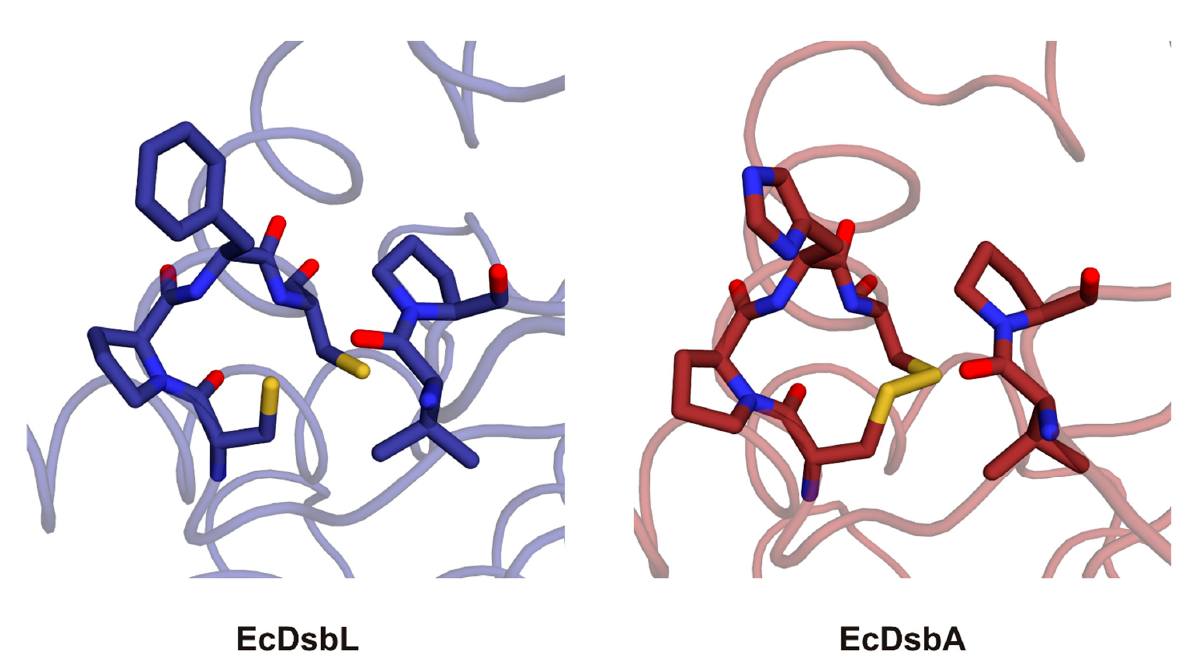
Figure 8. Comparison of active sites of CjDsbA1 (yellow) and CjDsbA2 (green) with previously known EcDsbL (blue) and EcDsbA (red). Main chain trace is shown as a tube and CXXC and cis-proline motifs are shown as sticks.